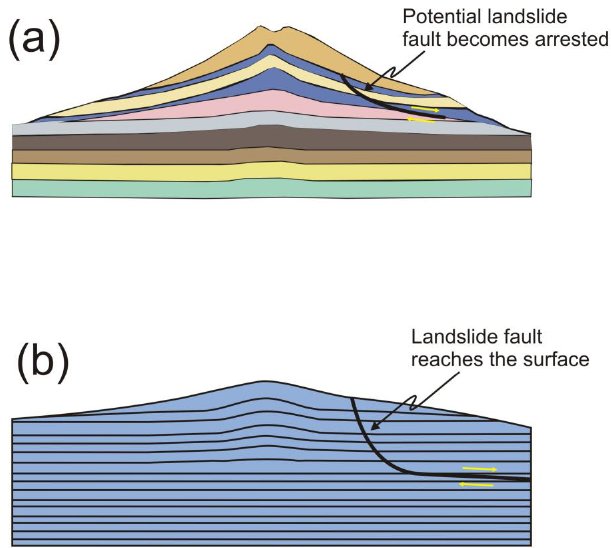
Fig. 14. For a large landslide to occur in a volcanic edifice, the shear-fracture (the landslide fault or slip surface) must reach the surface along the slopes of the volcano; if the fracture becomes arrested, no major landslide can occur. The tendency for a potential landslide fault to become arrested is normally greater in a stratovolcano (a) than in a basaltic edifice (b).